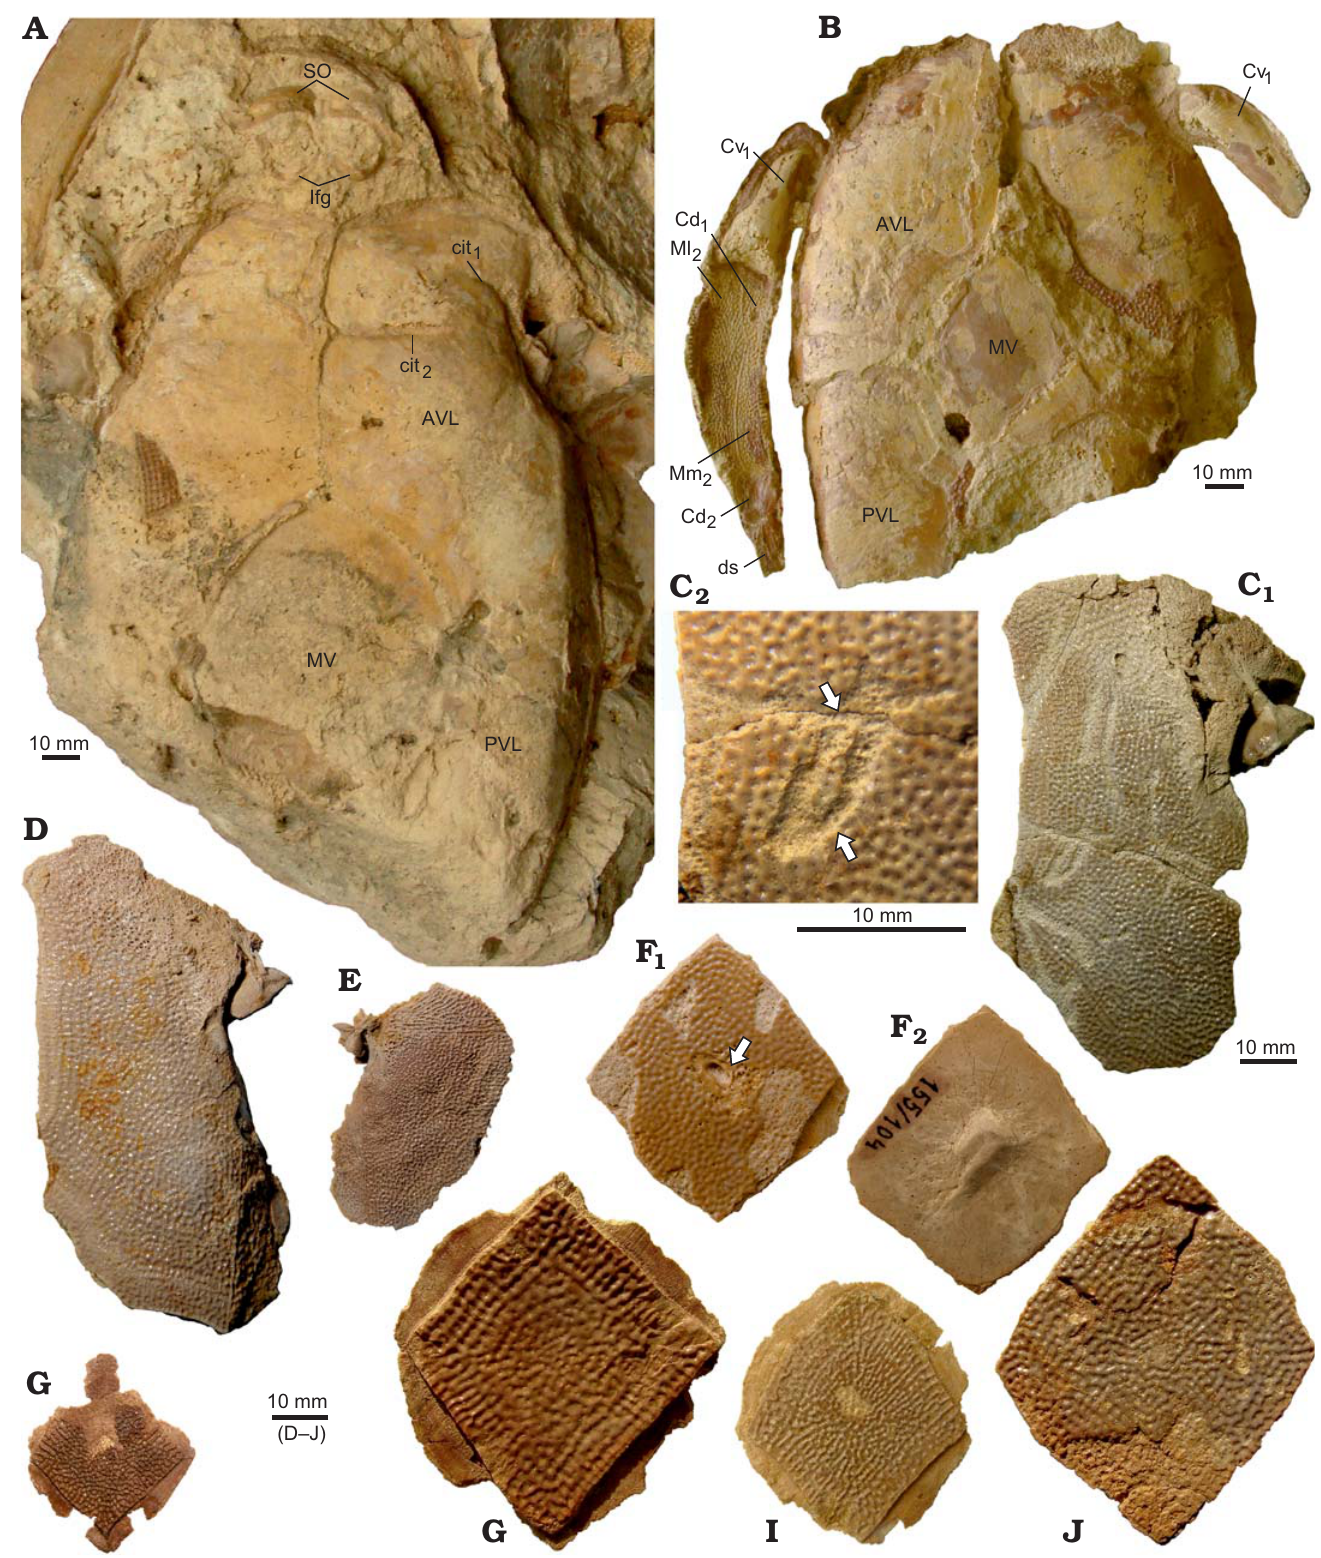
Fig. 11. Antiarchan fish Bothriolepis leptocheira jeremejevi (Rohon, 1900), Sosnogorsk locality, Sosnogorsk Formation, lowermost Famennian, partial ventral wall (A, B), anterior ventro-lateral (AVL) (C, D, left; E, right), and median ventral (F–J) plates of the trunk armour, and elements of pectoral fin. A . Impression of partial ventral wall of the trunk armour, inferognathals, and suborbitals IG KSC 155/10-2 in ventral view. B . Partial ventral wall of the trunk armour with articulated pectoral fin armour IG KSC 155/10-1 in ventral view. C . IG KSC 155/151 (C 1 ) and enlargened part of the ventral lamina with pathologies (C 2 , arrows). D . IG KSC 155/122 in ventral view. E . IG KSC 155/123 in ventral view. F . IG KSC 155/104 with the bite mark (arrow)